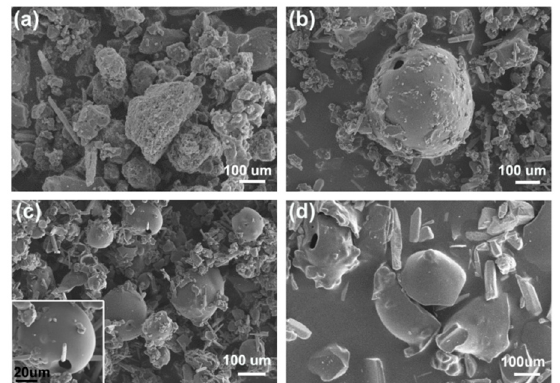
Figure 5. SEM images of ( a ) control and ( b-d ) lignin-based carbon materials in 40 wt % ZnCl 2 solution using ( b ) microwave, ( c ) ultrasound, and ( d ) UV irradiation, respectively.